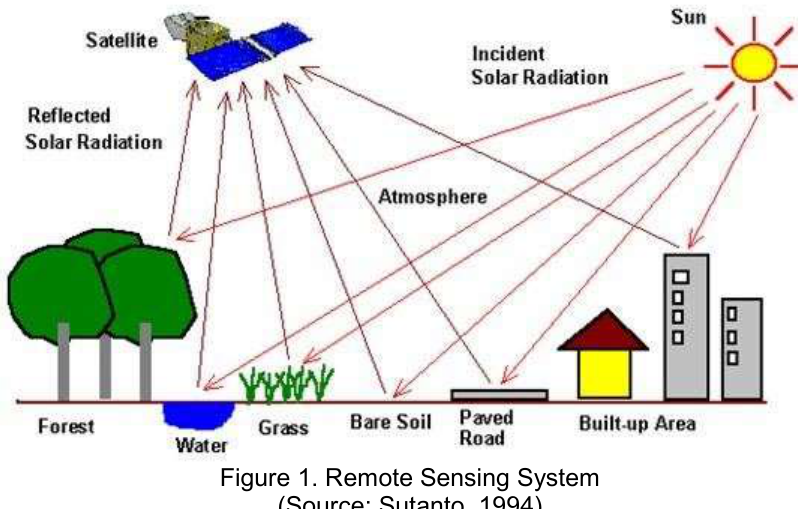
Figure 1. Remote Sensing System (Source: Sutanto,